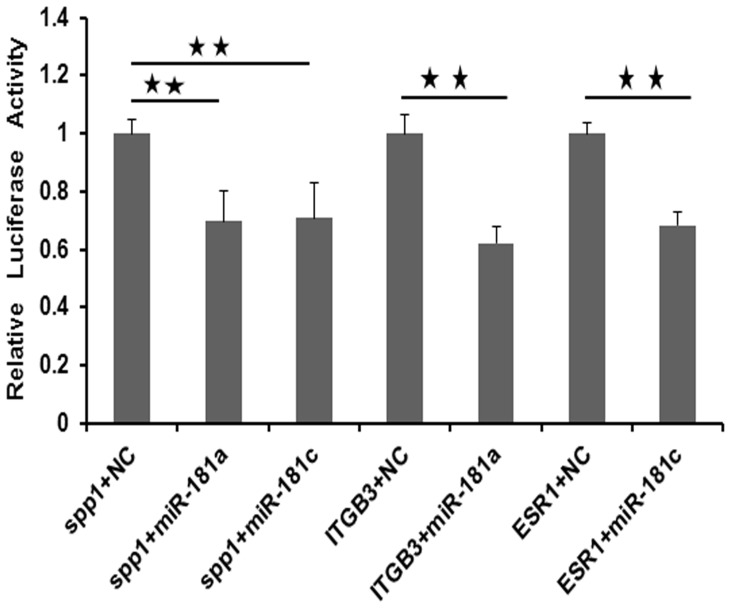
The result of luciferase assay for SPP1, ITGB3 and ESR1 targeting by miR-181a and miR-181c.The error bars show the SEM. The significance of differences was calculated using two-tailed T-test. *, p<0.05; **, p<0.01.